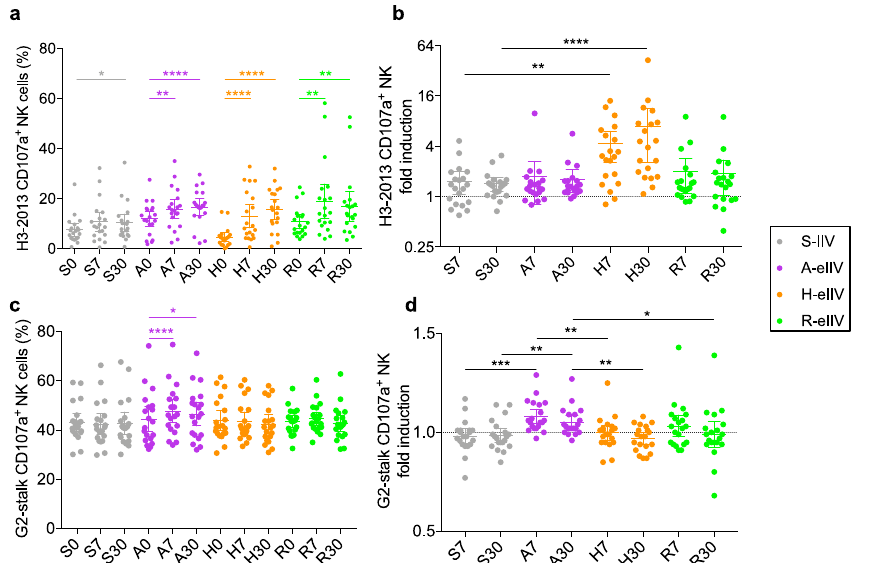
Fig. 2 Boosting of ADCC responses by seasonal in fl uenza vaccines against H3-2013 hemagglutinin and G2-stalk protein. Frequency (%) of H3-2013 HA-speci fi c CD107a + NK cells ( a ) and fold induction ( b ). Frequency of G2-stalk-speci fi c CD107a + NK cells ( c ) and fold induction ( d ). Friedman ’ s test for within-group and Kruskal – Wallis test for between-group comparison was performed. * p < 0.05, ** p < 0.01, *** p < 0.001, **** p < 0.0001 versus day 0 or comparison group, as indicated. Data represented as mean ( n = 20 per vaccine group) with 95%